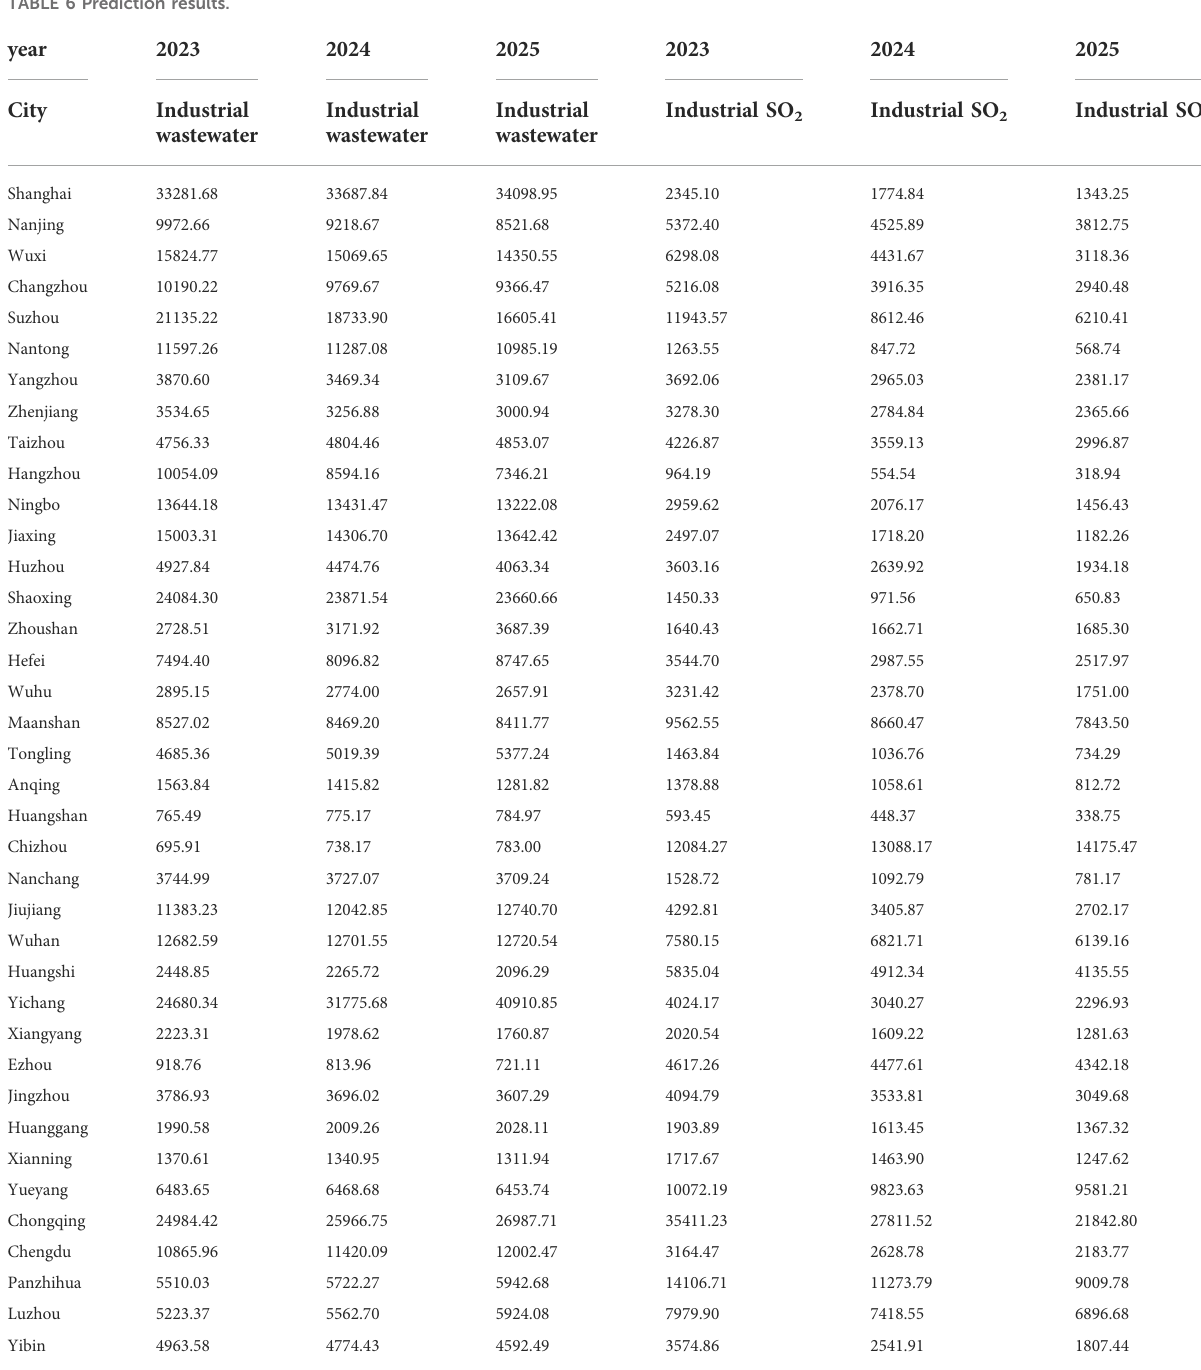
TABLE 6 Prediction